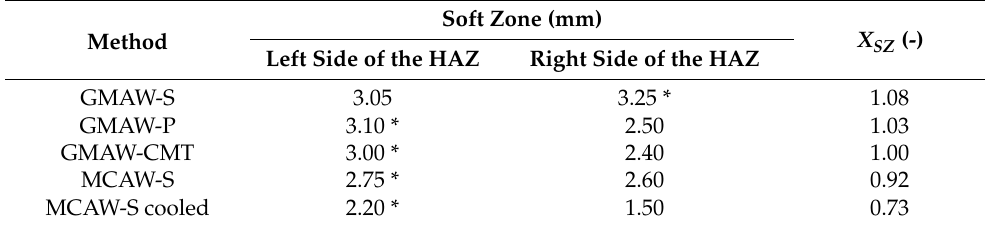
Table 7. Values of the width of the soft zones and the relative thicknesses of the soft zones ( X SZ ).